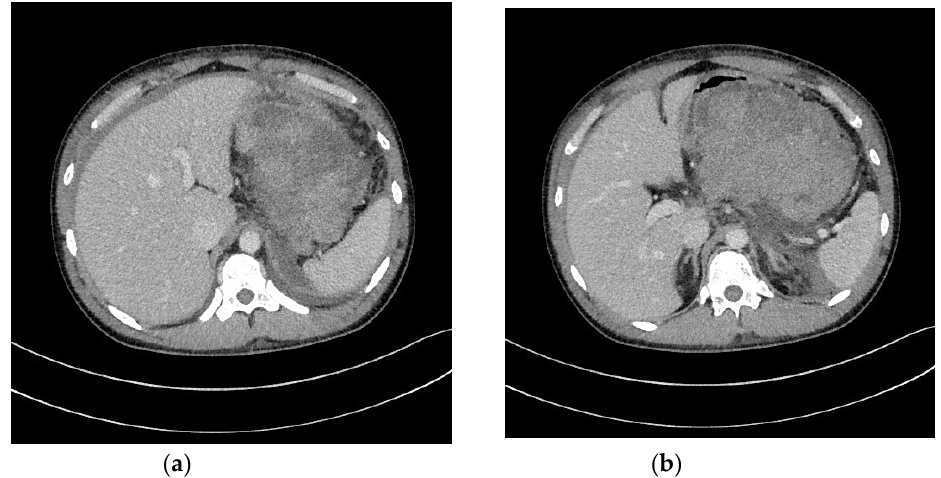
Figure 1. ( a , b ) Abdominal CECT was obtained in a 24-year-old male with ANP on day 9. In the pancreatic area, an ANC can be seen. ANC, acute necrotic collection; ANP, acute necrotizing pancreatitis; CECT, contrast-enhanced computed tomography.